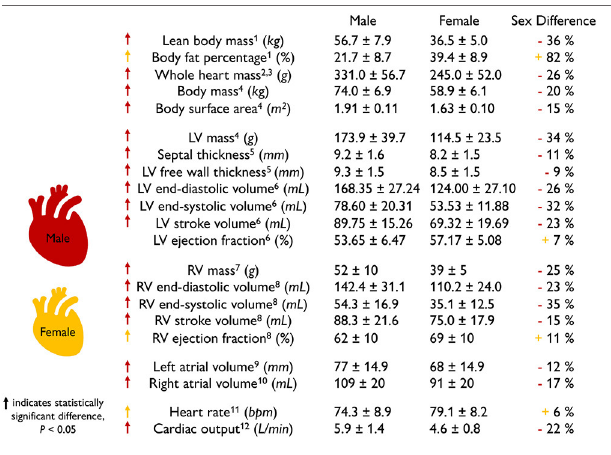
TABLE 1 | Sex differences in healthy heart geometry and